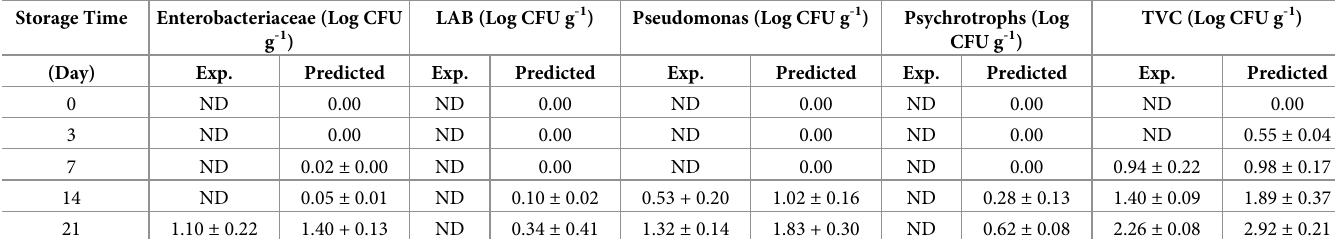
Table 1. Experimental (Exp.) and predicted values of microbial count (Log CFU g -1 ) of sous-vide samples processed at 80˚C. Storage Time Enterobacteriaceae (Log CFU g -1